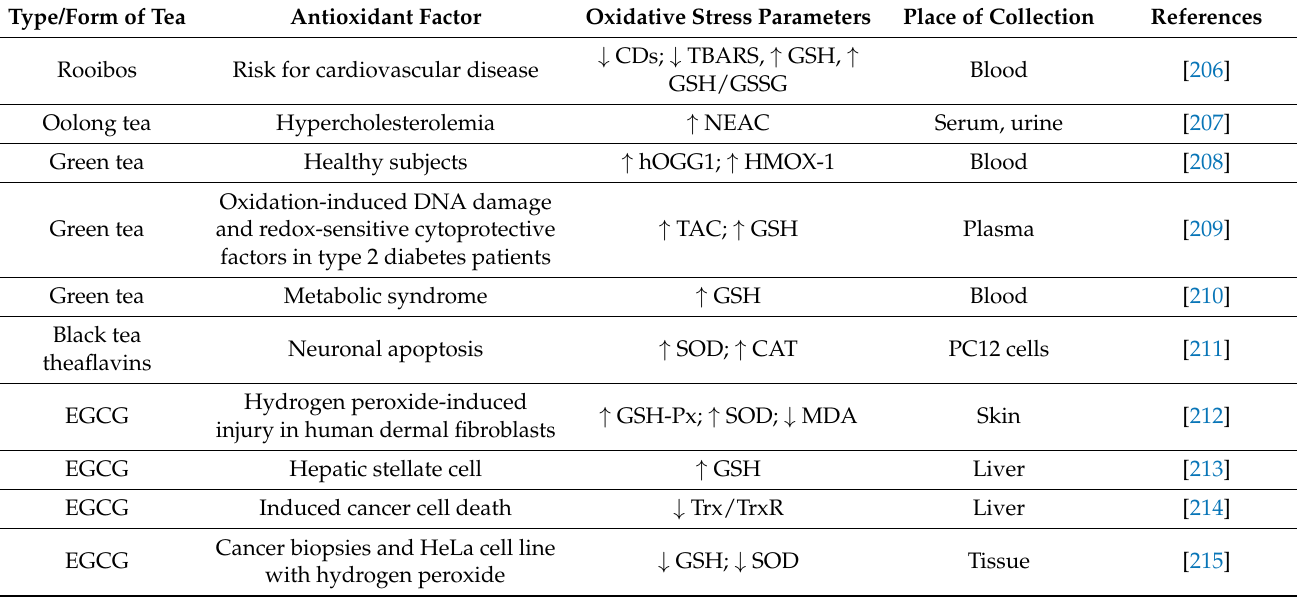
Table 3. The effect of tea and tea active compounds on oxidative stress-related alterations in